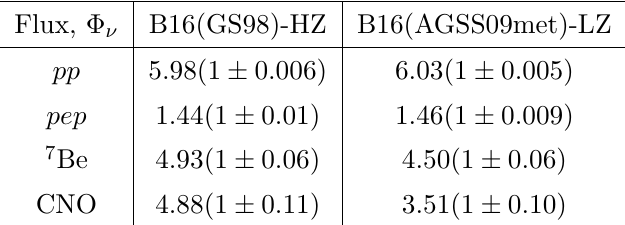
Table 1 . The (cid:13)uxes predicted by HZ- and LZ-SSM’s (ref. [27]) and used in this analysis. Units are: 10 10 ( pp ), 10 9 ( 7 Be), 10 8 ( pep , CNO) cm (cid:0) 2 s (cid:0) 1